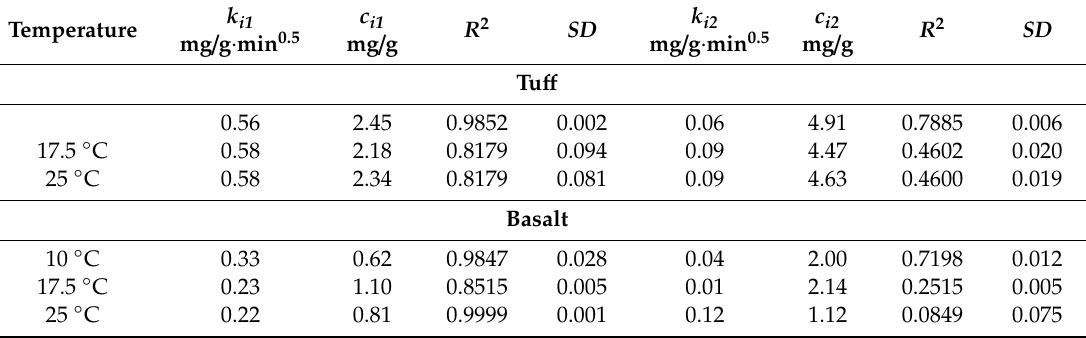
Table 5. Parameters of intraparticle di ff usion model, characterized by coe ffi cient of determination and standard